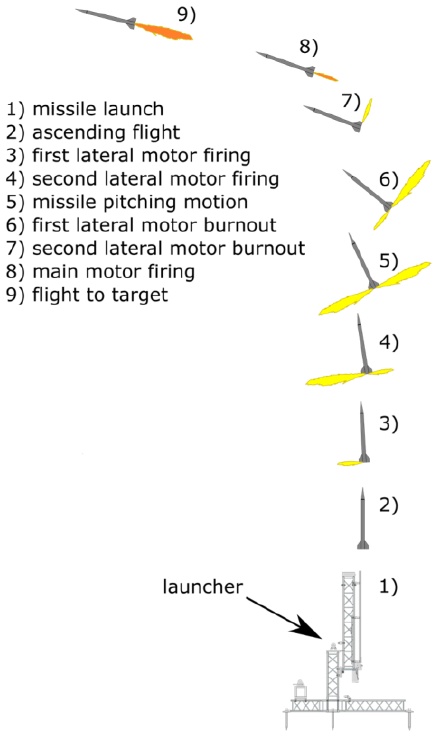
Figure 1. Cold vertical launch concept.